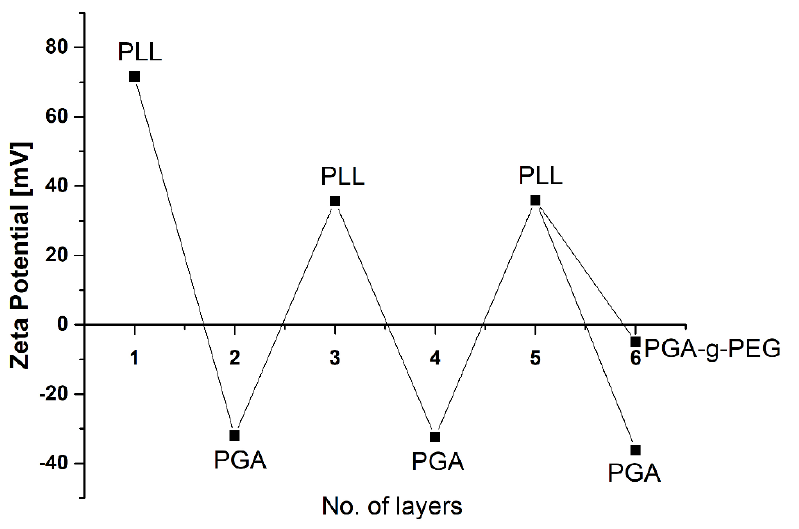
Figure 3. Dependence of the zeta potential of polyaminoacid core-shell nanocarriers on the adsorp- tion of subsequent polyelectrolytes’ layers (PLL—Poly(L-lysine), PGA—poly(l-glutamic acid), and PGA-g-PEG Poly(l-glutamic acid)-g-poly(ethylene glycol) .